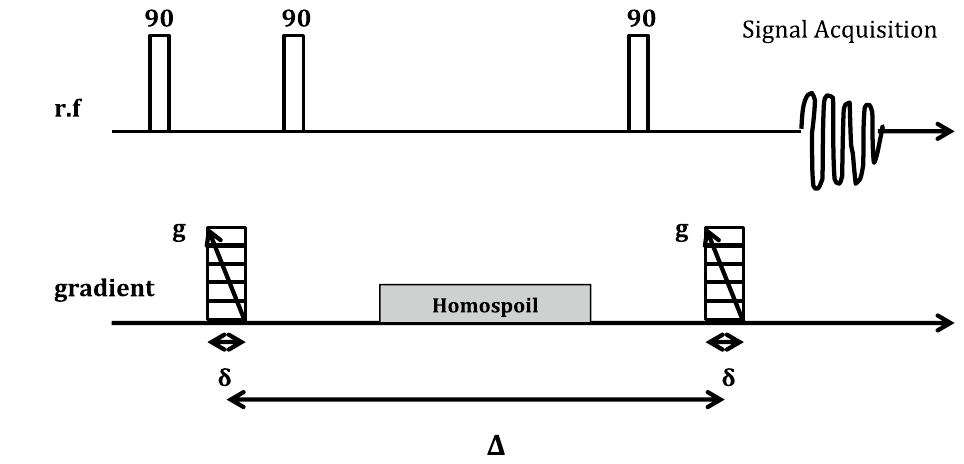
Fig. 3 Stimulated echo pulsed field gradient (STE PFG) pulse sequence used for diffusion measurements